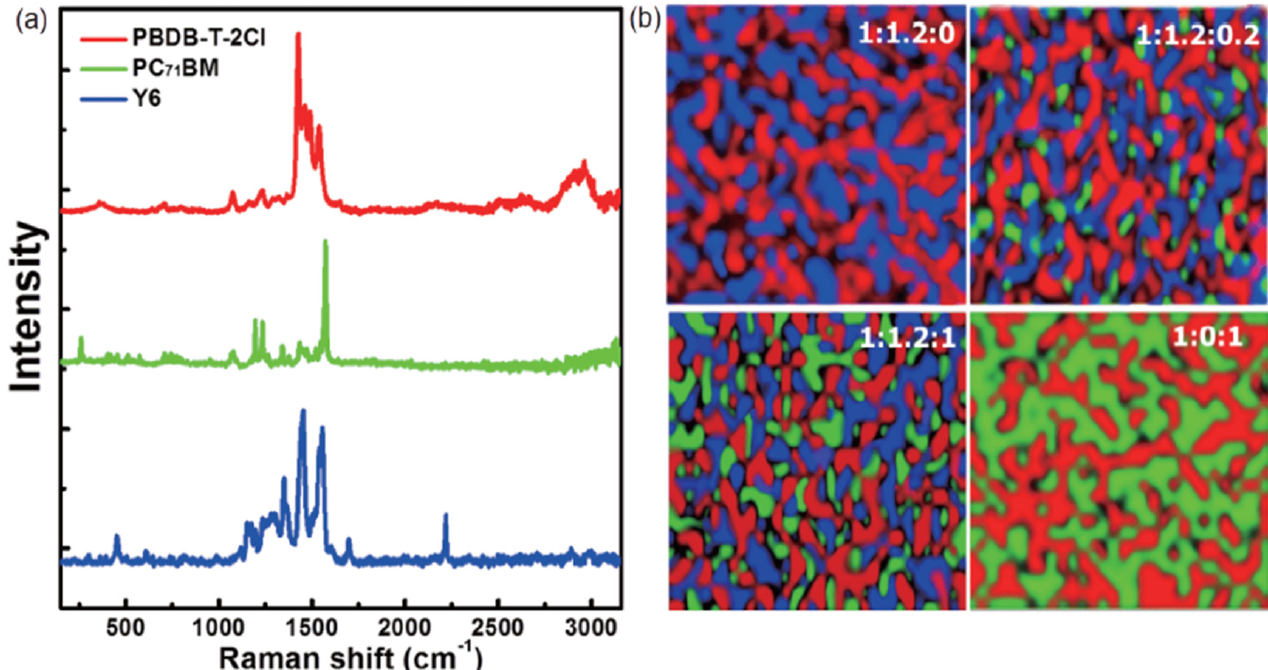
Figure 8. ( a ) Raman spectra of three materials: PBDB-T-2Cl, PC 71 BM and Y6; ( b ) Raman mapping image of ternary blend films with different PC 71 BM contents. Reproduced from [94]. Reprinted with permission from ref. [94]. Copyright 2019 Science China Chemistry.